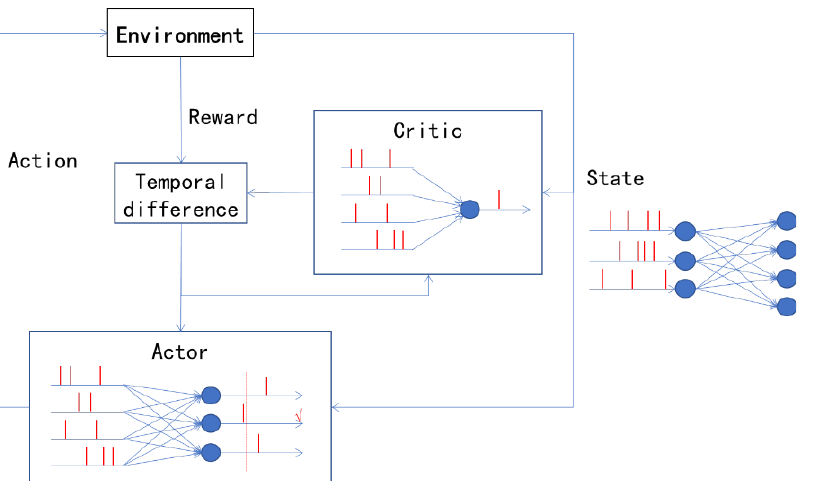
Figure 4. The spike neural network using actor-critic architecture. (The outputs of action neurons and critic neurons are temporally coded by the neurons’ first spiking moments. Links between state neurons and output neurons are synapses that decide how fast the output neurons fire a spike. First spike time changes when synapse weight values change.)